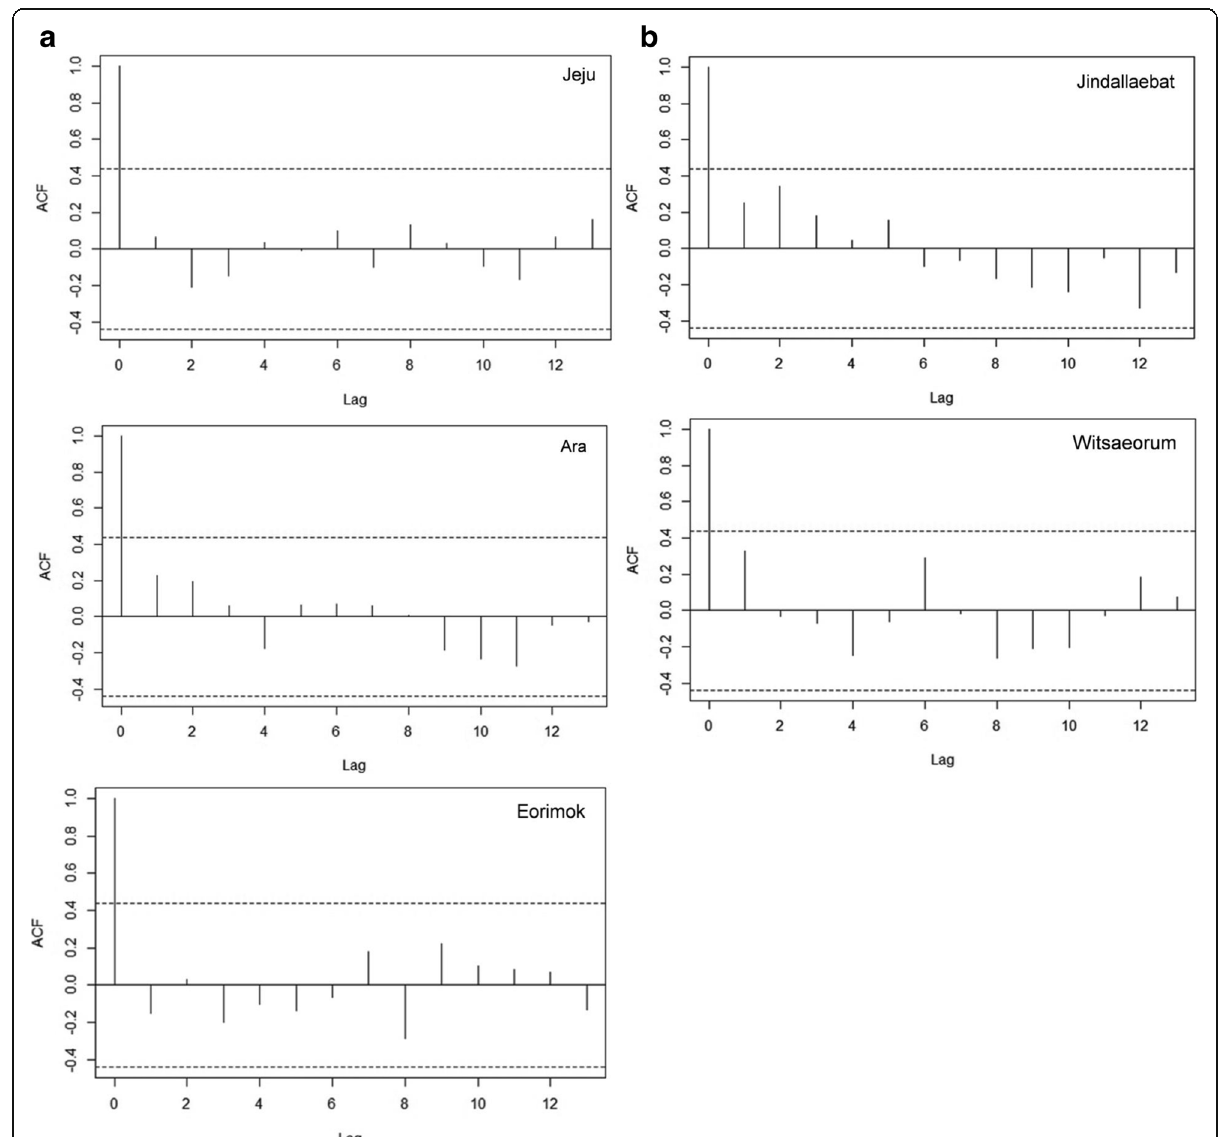
Fig. 3 a Autocorrelation function (ACF) plot of Jeju, Ara and Eorimok station. b Autocorrelation function (ACF) plot of Jindallaebat and